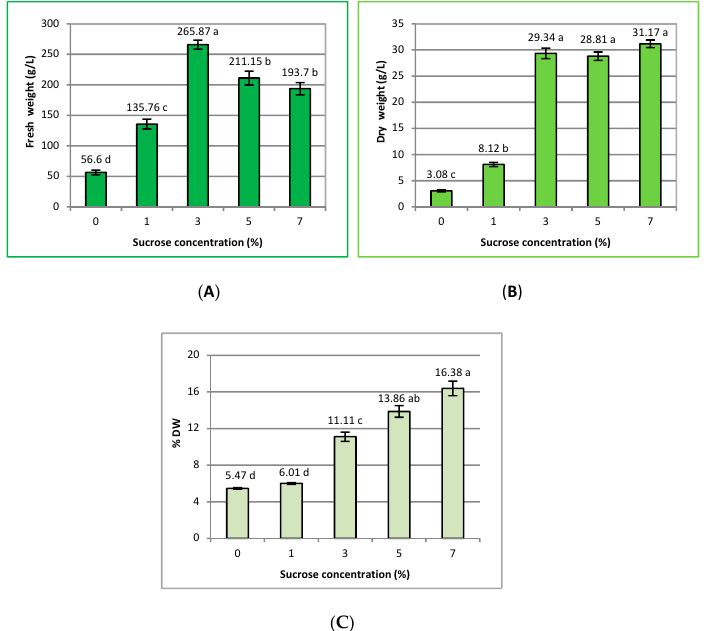
Figure 2. Effect of sucrose concentration (0–7%) on ( A ) fresh weight (g L − 1 ), ( B ) dry weight (g L − 1 ), and ( C ) % of dry weight of R. carthamoides transformed roots cultured in 50 mL of liquid WPM medium in a 300 mL Erlenmeyer flask, in light conditions (16/8-h light/dark photoperiod) on a rotary shaker at 80 rpm. The results are means values ± SE. The experiments were repeated three times ( n = 9). Different letters signify significant differences between the sucrose concentrations ( p < 0.05).